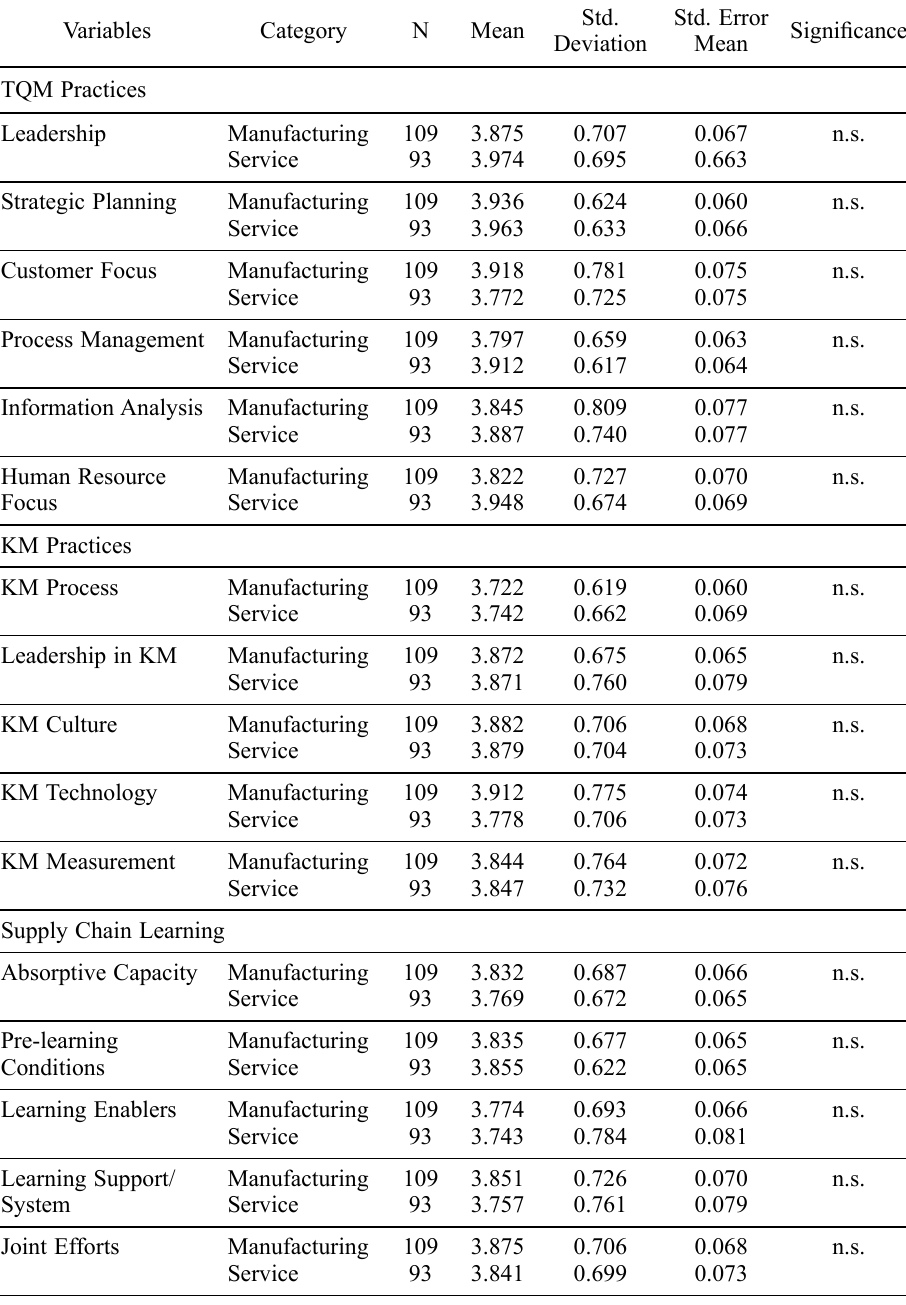
Table 3. Independent T-Tests statistics for estimating difference in responses between manufacturing and service